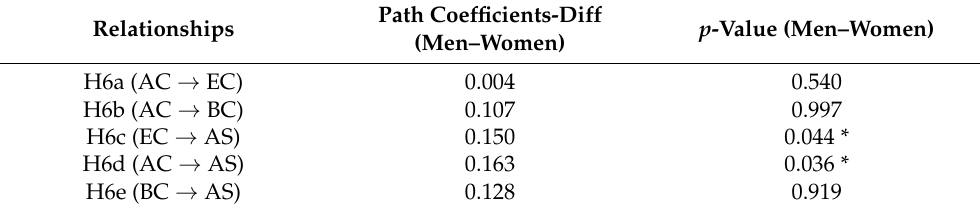
Table 5. Multi-group comparison test results. Relationships